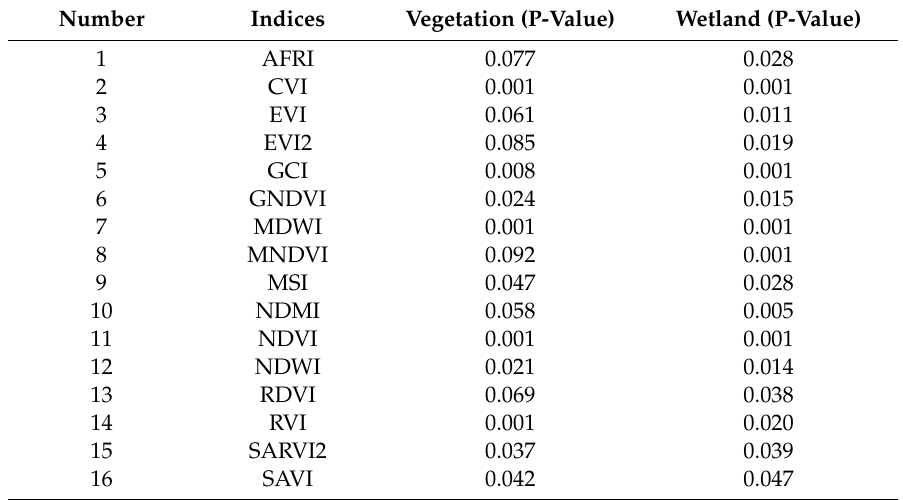
Figure 6. ( a ) RF normalized importance value; ( b ) SVM normalized importance value. Table 9. Significance value of the different indices before and after oil spill across the two classes (vegetation and wetland) using Pair T-test.